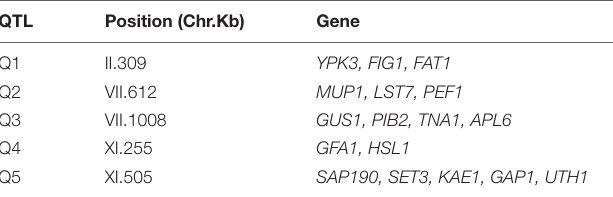
TABLE 2 | Selected candidate genes for each